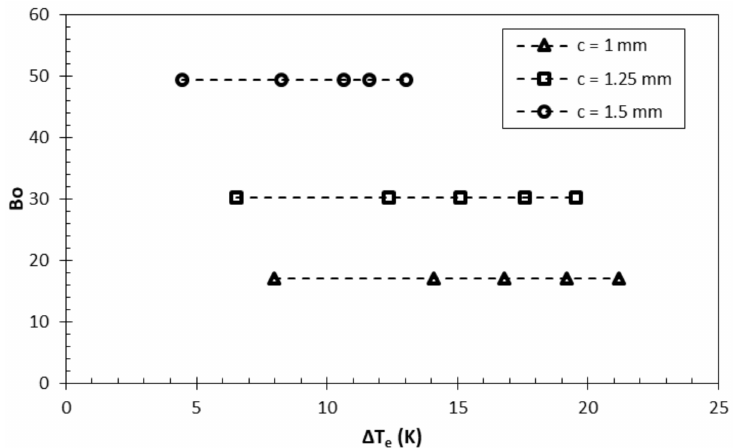
Figure 15. The plot of Bond number from different circular pin fin